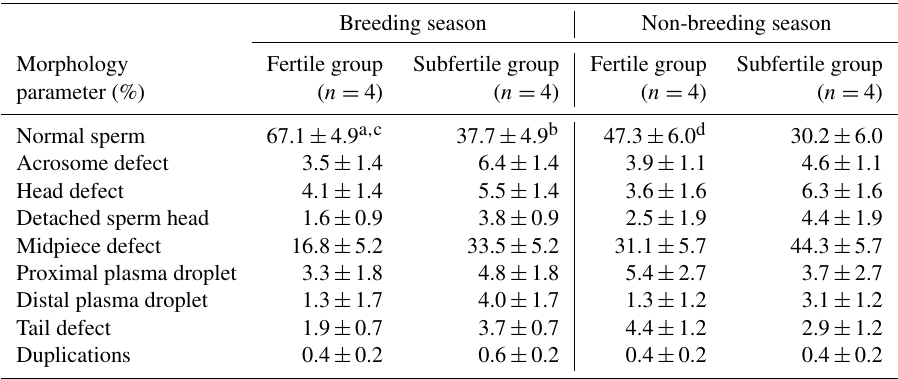
Table 2. Percentage of morphological intact and defect spermatozoa of chilled semen collected from fertile and subfertile stallions during breeding and non-breeding season (least-square means ±